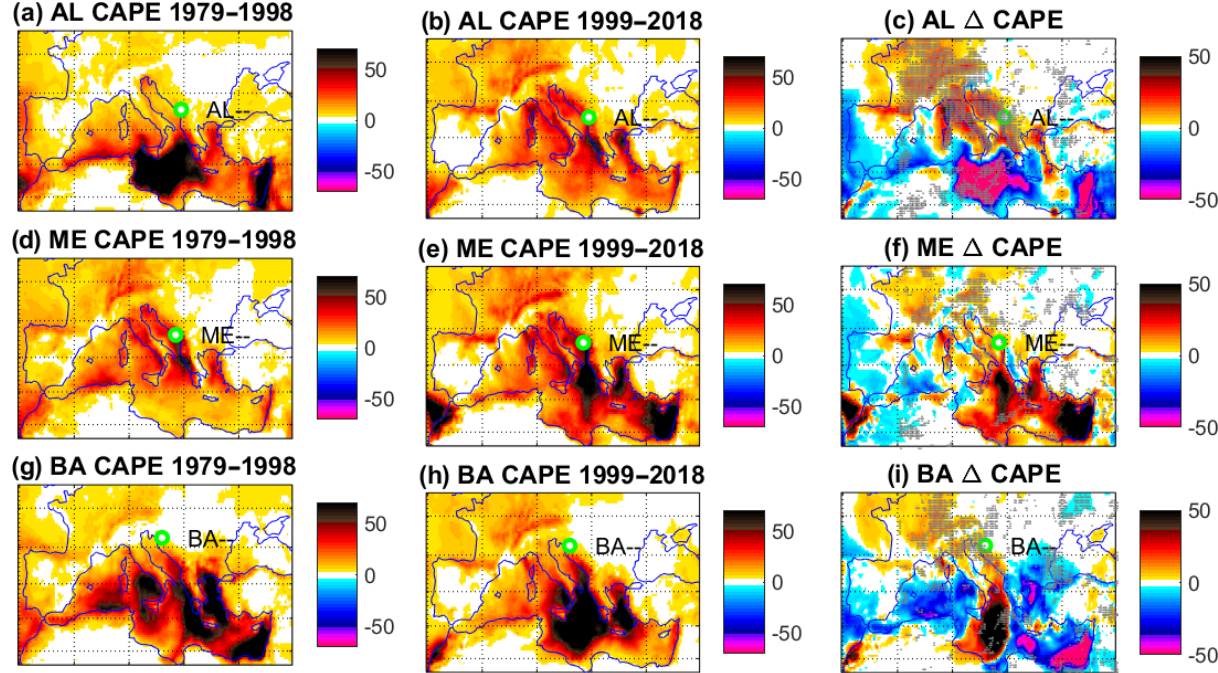
Figure 7. Average of convective available potential energy (CAPE) fields (Jkg − 1 ) during days of yearly maximum snowfall for the periods 1979–1998 (a, d, g) and 1999–2018 (b, e, h) . Panels (c) , (f) and (i) show the differences between the second and the first periods ( (cid:49) CAPE). (a, b, c) Albania (AL), (d, e, f) Montenegro (ME), (g, h, i) Bosnia (BA). Green circles show the location of the northwesternmost point of each country. Shaded areas represent grid points where at least two-thirds of the anomalies have the same